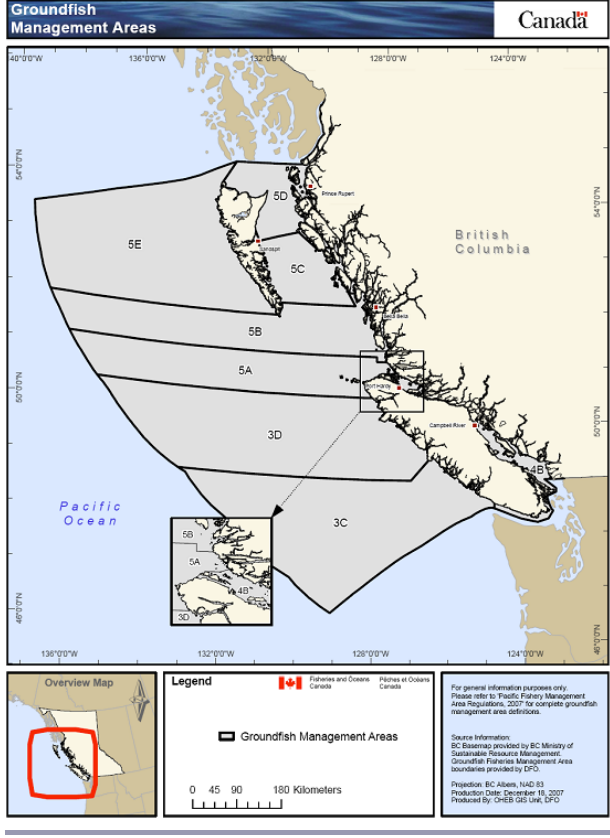
Fig. 2 . Commercial groundfish management area map (Source: DFO 2012 b